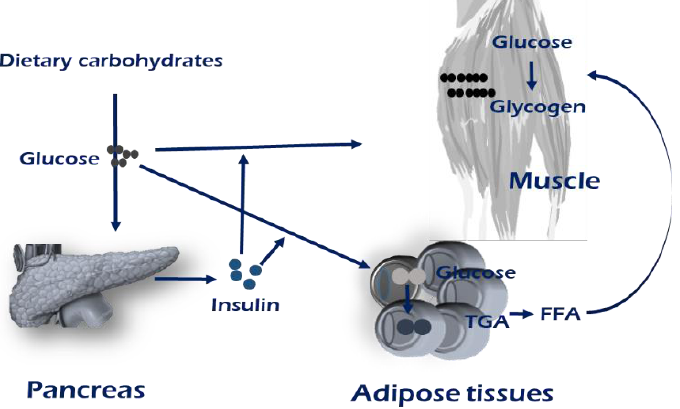
Figure 1 . Brief overview of maintenance of energy homeostasis. Insulin stimulates the conversion of glucose into glycogen or triglycerides by increasing glucose uptake in muscle and adipose tissue. The majority of insulin-stimulated glucose uptake occurs in skeletal muscle. In obese, insulin-resistant, or T2D patients, an increased intramuscular TAG concentration has been linked with a reduced oxidative capacity, which could lead to fatty acid (FA) storage, and thereby provide a mechanism for lipid accumulation within skeletal muscle. Mechanisms regarding PI3K-AKT-mTOR signaling are mentioned in main text and the Figure mentioned in main text and the Figure 2.